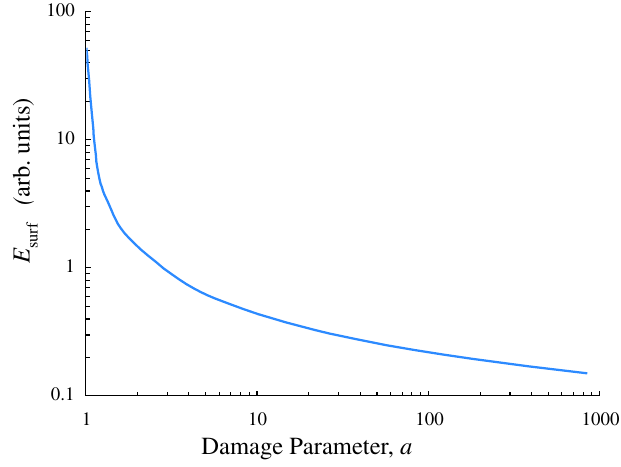
FIG. 5. (Color) The general dependence of the maximum sur- on the energy in the breakdown event assuming s face field E surf is an exponentially decreasing